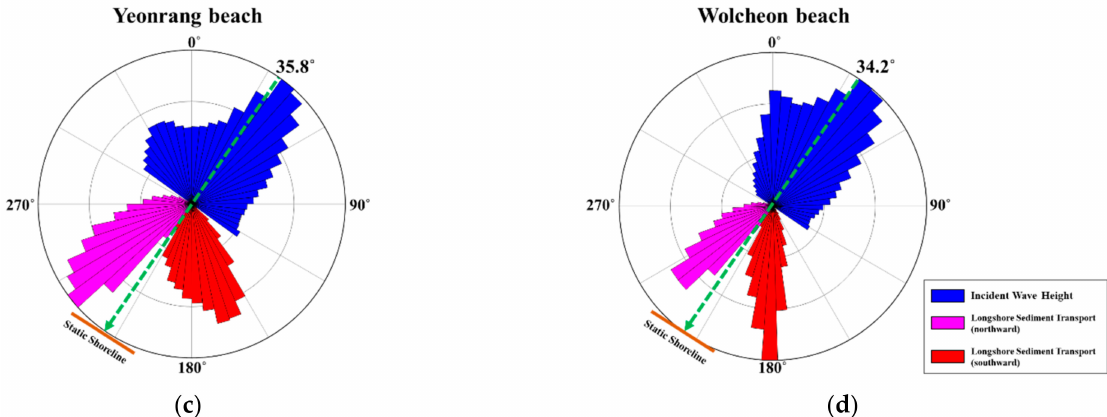
Figure 10. Rose diagram of wave and longshore sediment transport with respect to incident angle: ( a ) definition sketch, ( b ) Wonpyeong beach, ( c ) Yeongrang beach, and ( d ) Wolcheon beach.